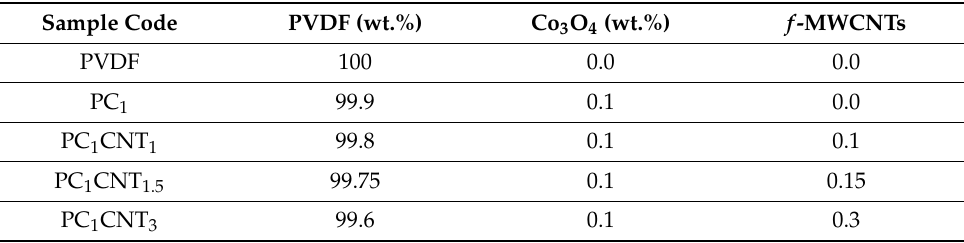
Table 1. Details of Co 3 O 4 and MWCNTs incorporation of different wt.% in PVDF matrix to prepare the resulting nanocomposite